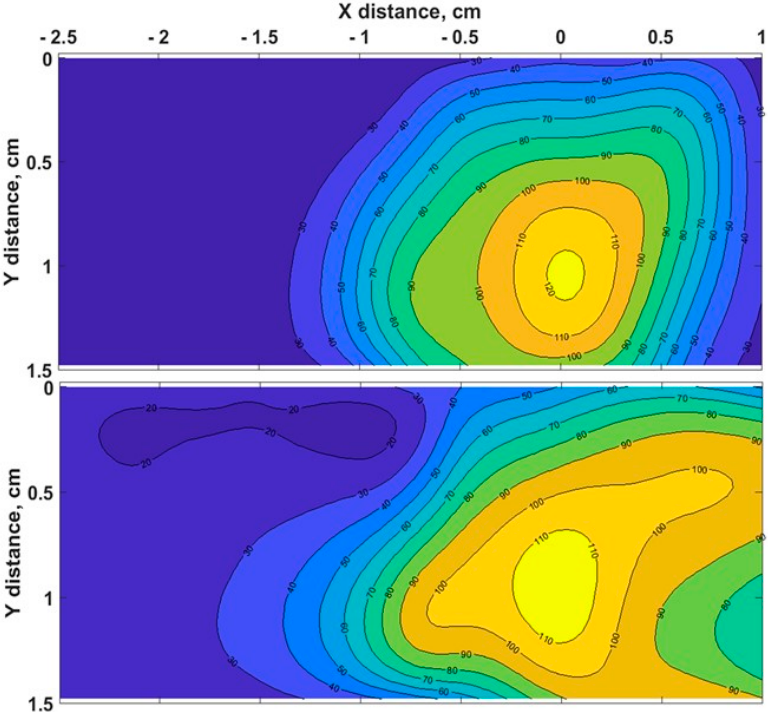
Figure 3. Typical two - dimensional thermal map of pristine chicken muscle (top) and tissues with AuNPs added (down) in the xy lateral plane (x = direction parallel to the RFA applicator and to the sensing fibers).